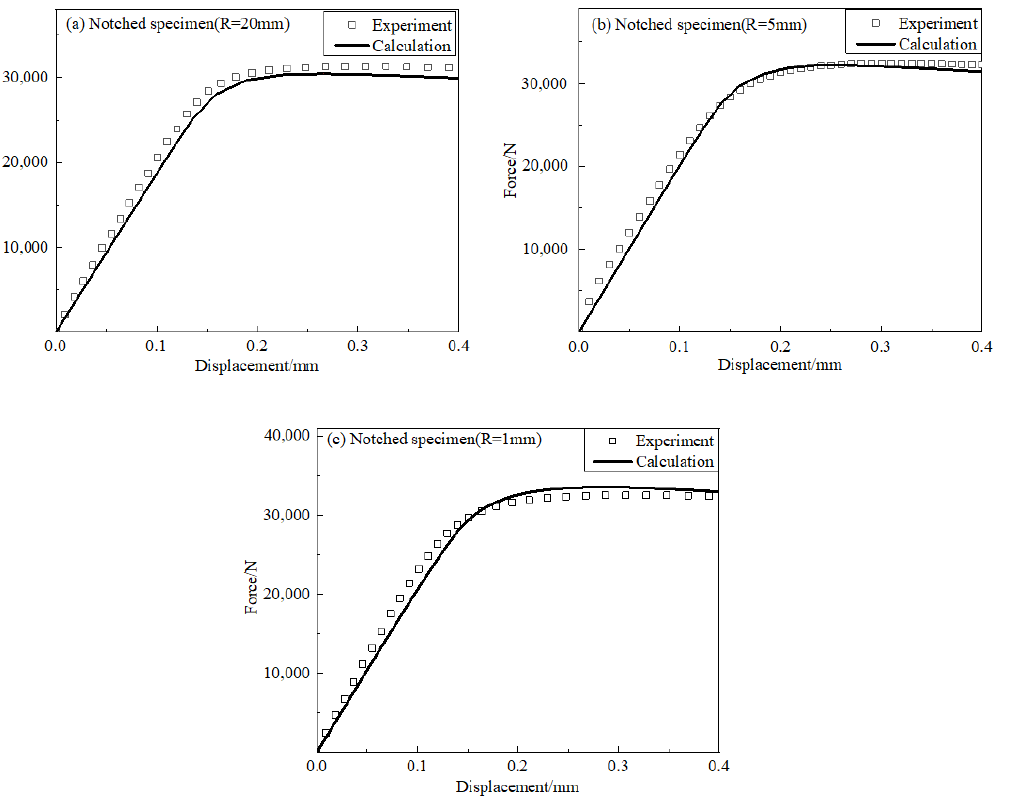
Figure 7. Displacement of notched specimens vs. force: ( a ) Notched specimen (R = 20 mm); ( b ) Notched specimen (R = 5 mm); ( c ) Notched specimen (R = 1 mm).